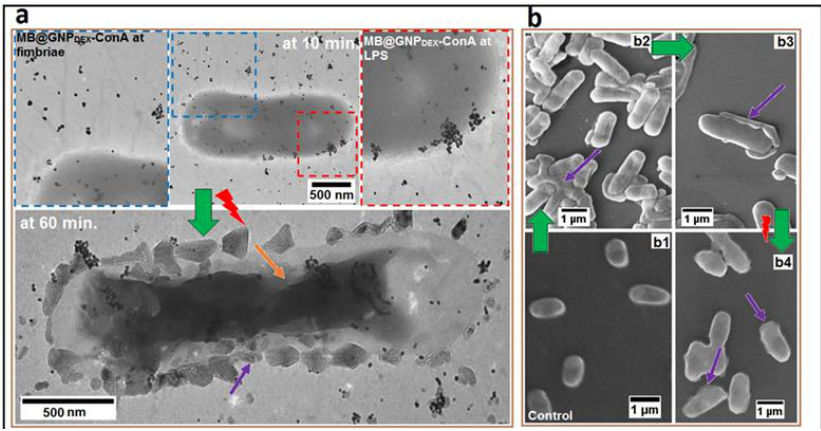
Figure 5. ( a ) TEM micrographs of localized MB@GNPDEX-ConA on K.Pneumoniae -12 bacterial surface and treated (for 100 s = 142.9 J cm −2 ) bacterial cell (after 60 min). The micrograph shows the cytological mass with aggregated nanoconjugates (yellow arrow) and cell surface perturbation (violet arrow). ( b ) The morphological perturbations shown by SEM micrographs. ( b , b1 ) The intact and uniform morphology of control cells and ( b , b2 , b3 ) bacterial aggregation due to concanavalin A (ConA)-mediated attachment of nanoconjugates (violet arrow). ( b , b4 ) The micrograph shows cell membrane destruction (violet arrow) after photosensitization. Reproduced from [78], with permission from Elsevier, 2017.